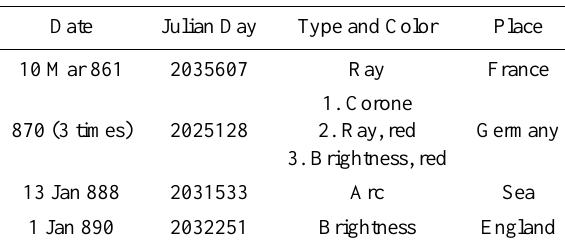
Table 2. Some aurorae during the 9th century described in Link (1962)